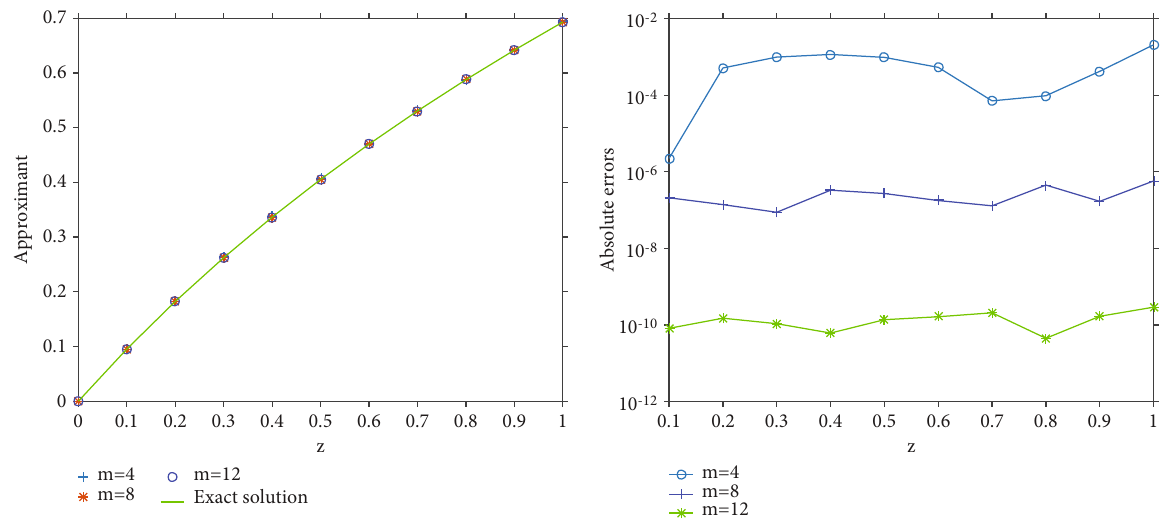
Figure 1: Approximate solutions and its corresponding absolute errors at di ff erent degrees of approximation m :